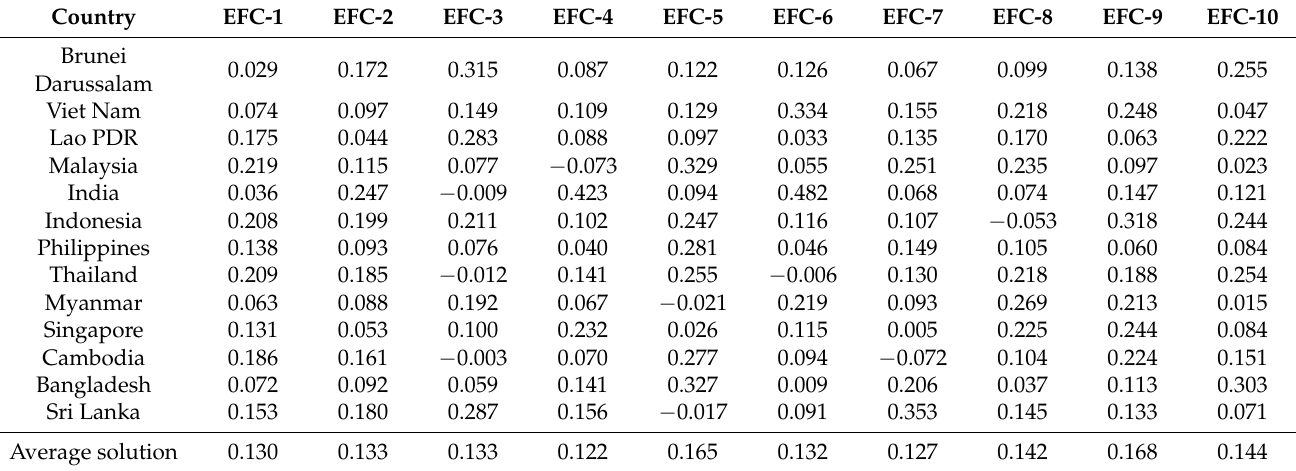
Table 8. Overall utility